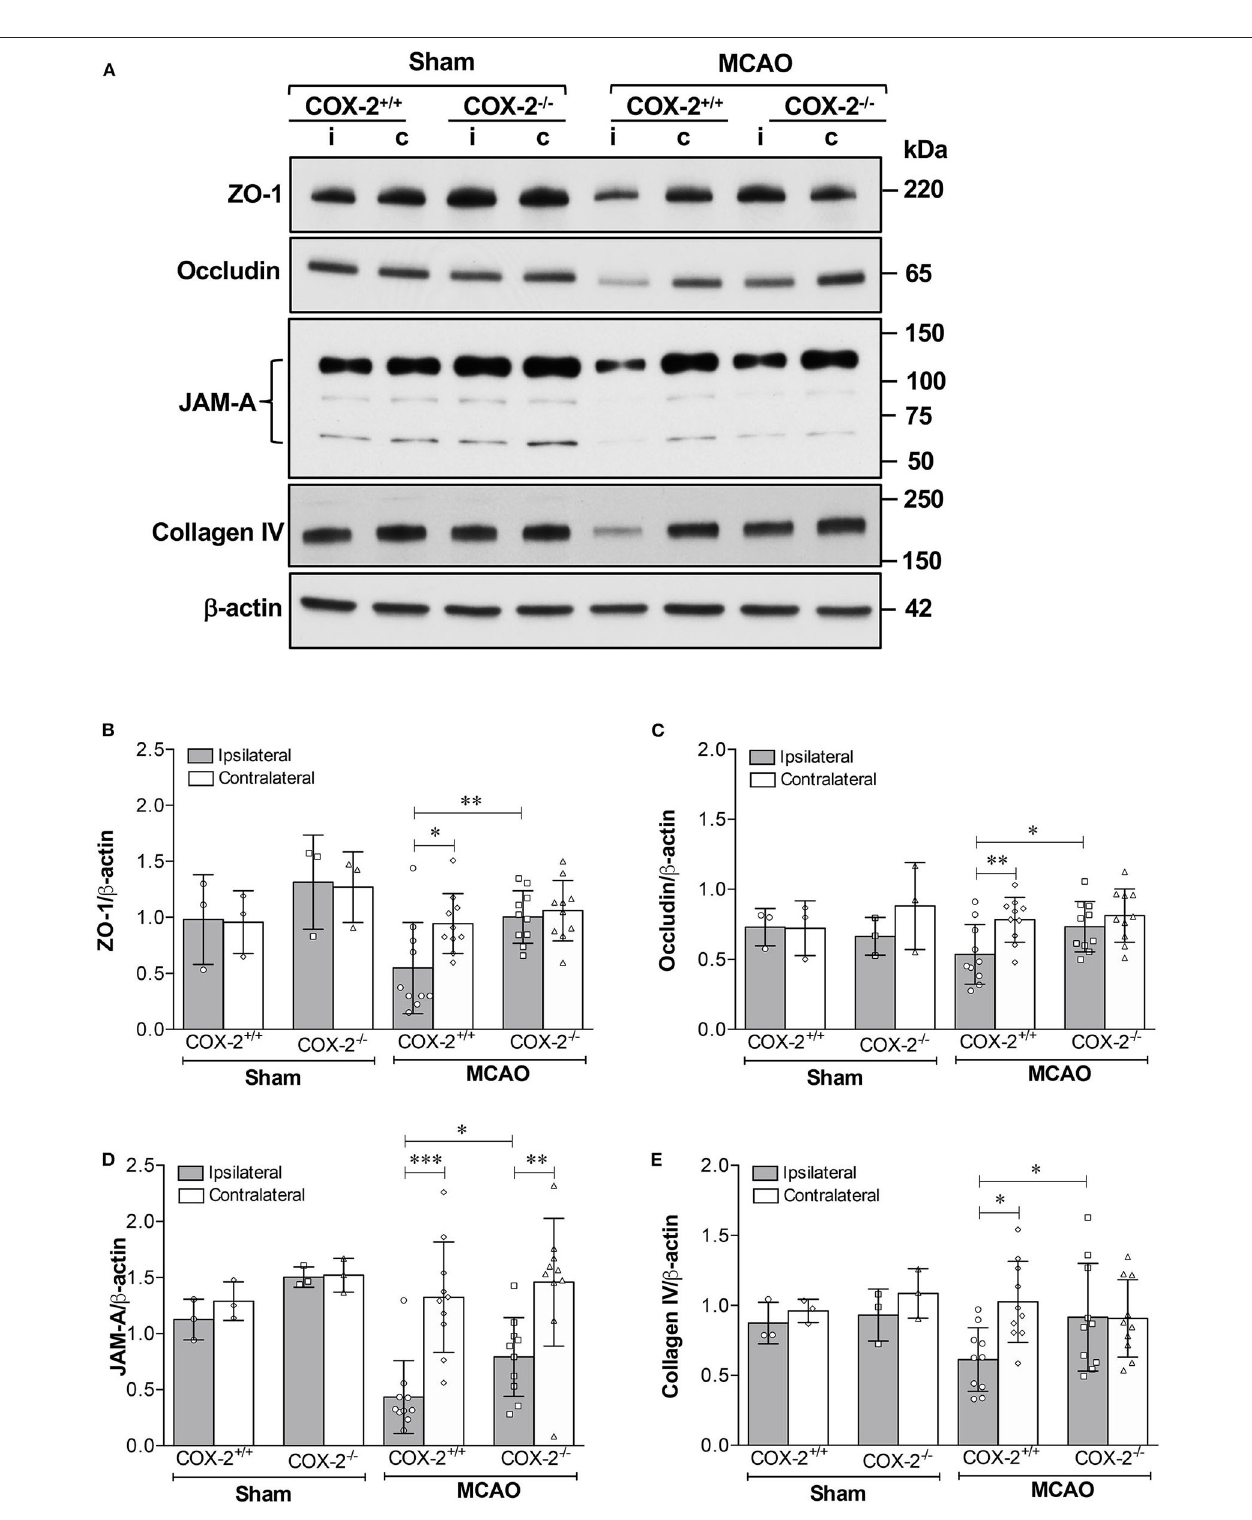
FIGURE 2 | Reduced damage to BBB structural components in COX-2 deficient mice after stroke. Ischemia-induced loss of proteins composing the tight junctions, adherens junctions, and basal lamina significantly increases BBB permeability. COX-2 null mice displayed a reduced loss of ZO-1, occludin, JAM-A, and collagen IV after ischemic stroke compared to wild-type controls. (A) Representative immunoblot images for several BBB structural proteins. i, ipsilateral; c, contralateral. Densitometric analyses normalized to β -actin are presented for ZO-1 (B) , occludin (C) , JAM-A (D) , and collagen IV (E) . Two-way ANOVA with Bonferroni post-tests. * P < 0.05, ** P < 0.01, and *** P < 0.001. Data are presented as mean ± SD. n = 10 in MCAO groups of each genotype. Sham-operated groups ( n = 3).